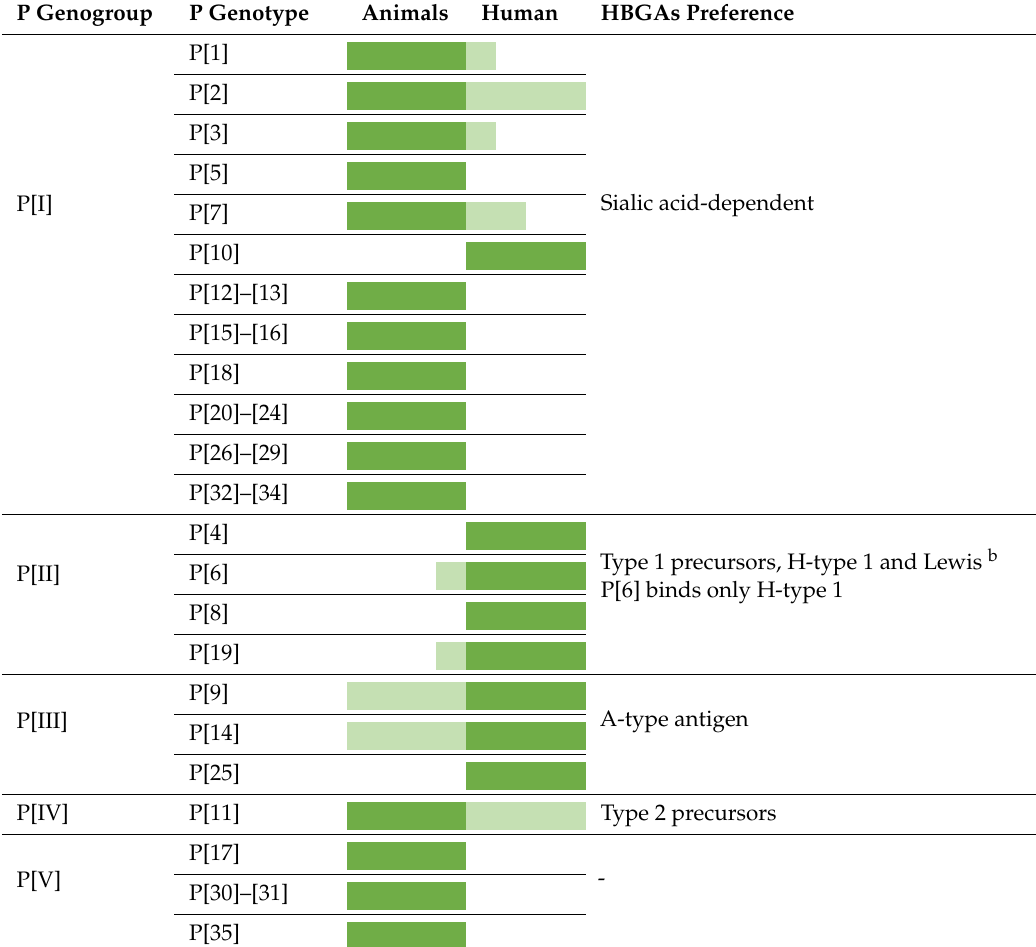
Table 4. Host range preferences for the rotavirus P genotypes and HBGAs